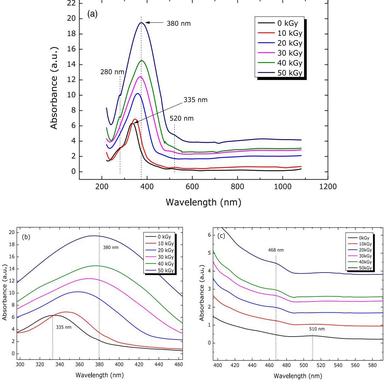
(a) UV–VIS spectrum of free-standing PVA/PANI/functionalized CNT nanocomposite film with different irradiation doses, (b) absorption band at λ = 300–460 nm and (c) absorption band at λ = 400–590 nm.